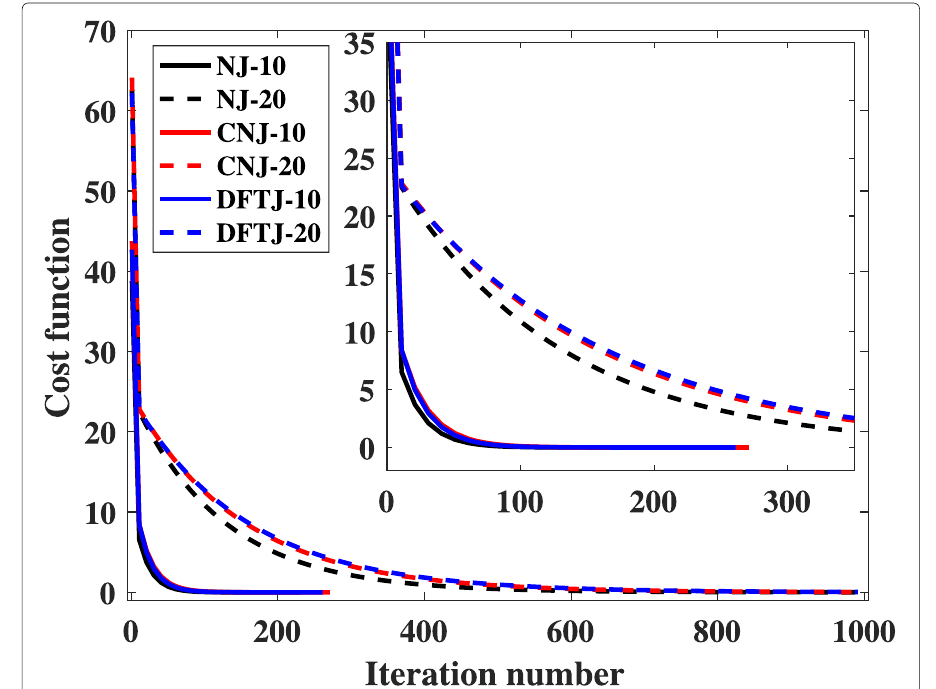
Fig. 5 Cost function in iteration process (SNR = 5 dB, JNR = 10 dB or JNR = 20